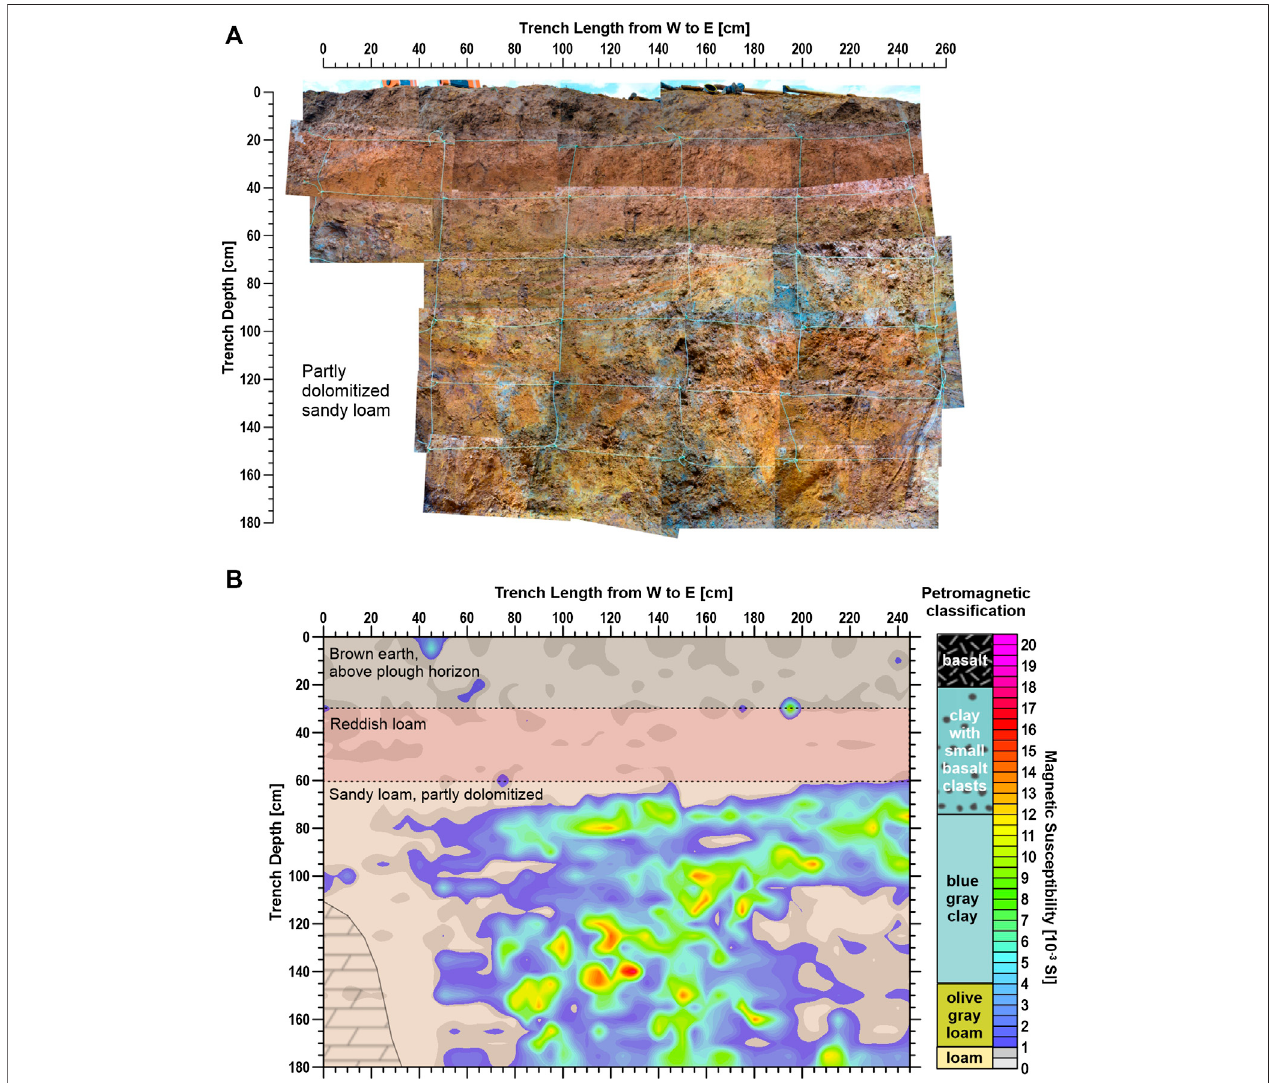
FIGURE2|(A) Photomosaicofexplorationtrenchwallwithstringsmarking25 × 50 cmsectors.Thedolomitizedsandstoneinthelowerleftwaslaterremovedand measured,butnotphotographed. (B) Schematichostsoilsectionswithoverlainmagneticsusceptibilitycontourplotbasedon in-situ susceptometrydatacollectedona 5 × 5 cmgrid.Low-magnetichostrocksoils(0 – 1 × 10 – 3 SI,gray)showpedoturbatedfringeswiththeochreandolive-graymedium-magnetic(1 – 4 × 10 – 3 SI,darktolight blue) and blue-gray high-magnetic (4 – 16 × 10 – 3 SI, green to yellow) basaltic weathering products. In 60 to 110 cm depth, basalt-derived clays are laterally protracted. The petromagnetic classi fi cation and color scheme at right associates basalt weathering stage with in-situ magnetic susceptibility.